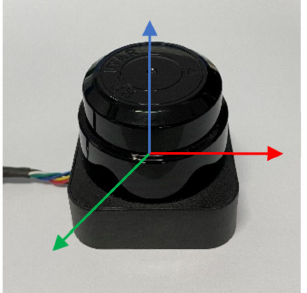
Figure 1. Single-line mechanical rotating